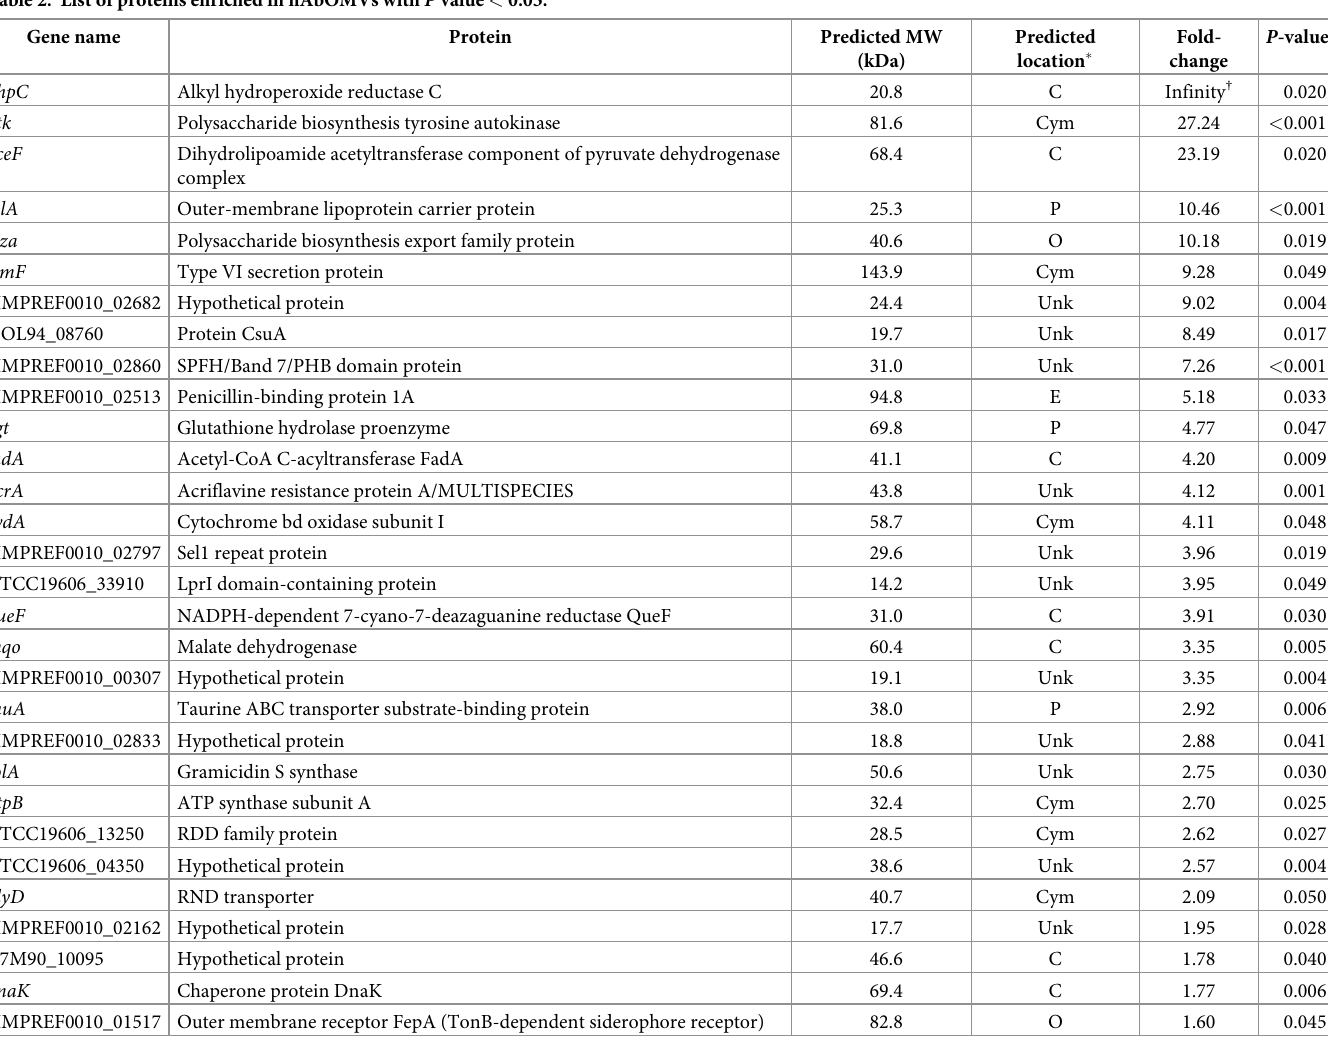
Table 2. List of proteins enriched in nAbOMVs with P value <